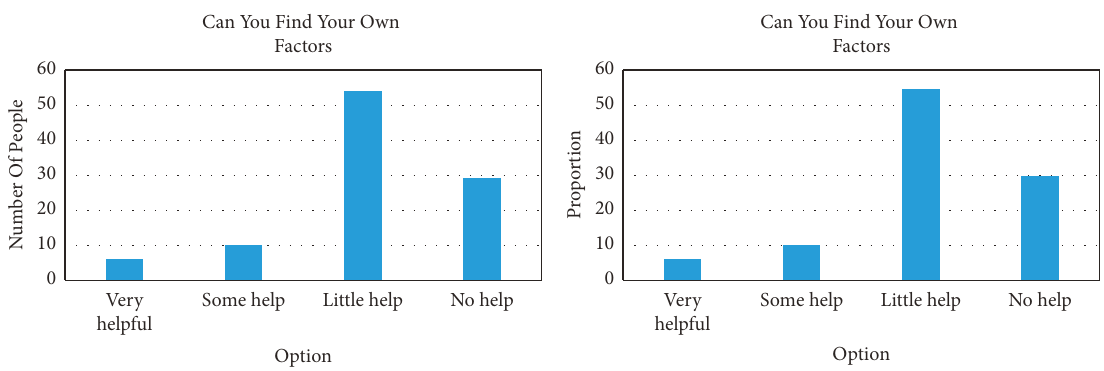
Figure 6: Whether the mental health education class can help discover one’s own factors.